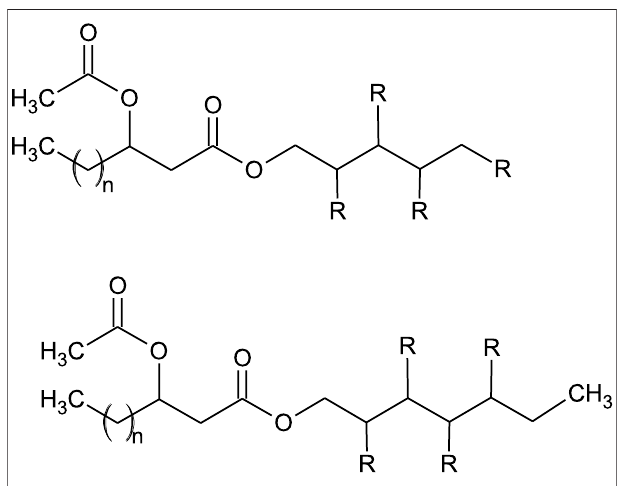
FIGURE 4 | General structure of PEFA (Garay et al., 2018). Where: R = OH or acetyl n = 8, 10, 12, 14,